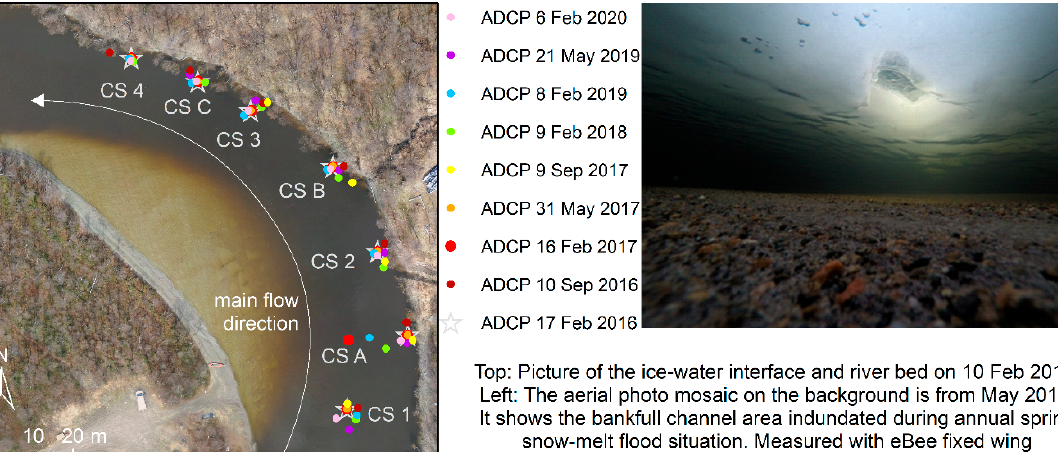
Figure 2. The acoustic Doppler current profiler (ADCP) measurement locations of each analyzed time period. The Global Positioning System (GPS) signals of 9 September 2017 measurements at CSC and CS4 (CS = cross-section) were not as good as in other measurement times, and therefore their exact measurement locations (yellow dots) are not shown on the map. Those were measured within the point clusters of CSC and CS4 of the other measurement times. Note that the measurement times on 25 May 2016 (spring), 23 May 2018 (spring), and 8 September 2018 (autumn) are not shown, since from those times only data from CS1 location were included in the analyses (see Section 3 and Table 1), and their locations were within the cluster of other CS1 measurements. The GoPro camera photograph shows the riverbed sediment and the low undulation of the ice-water interface at the CS1 on 10 February 2018.